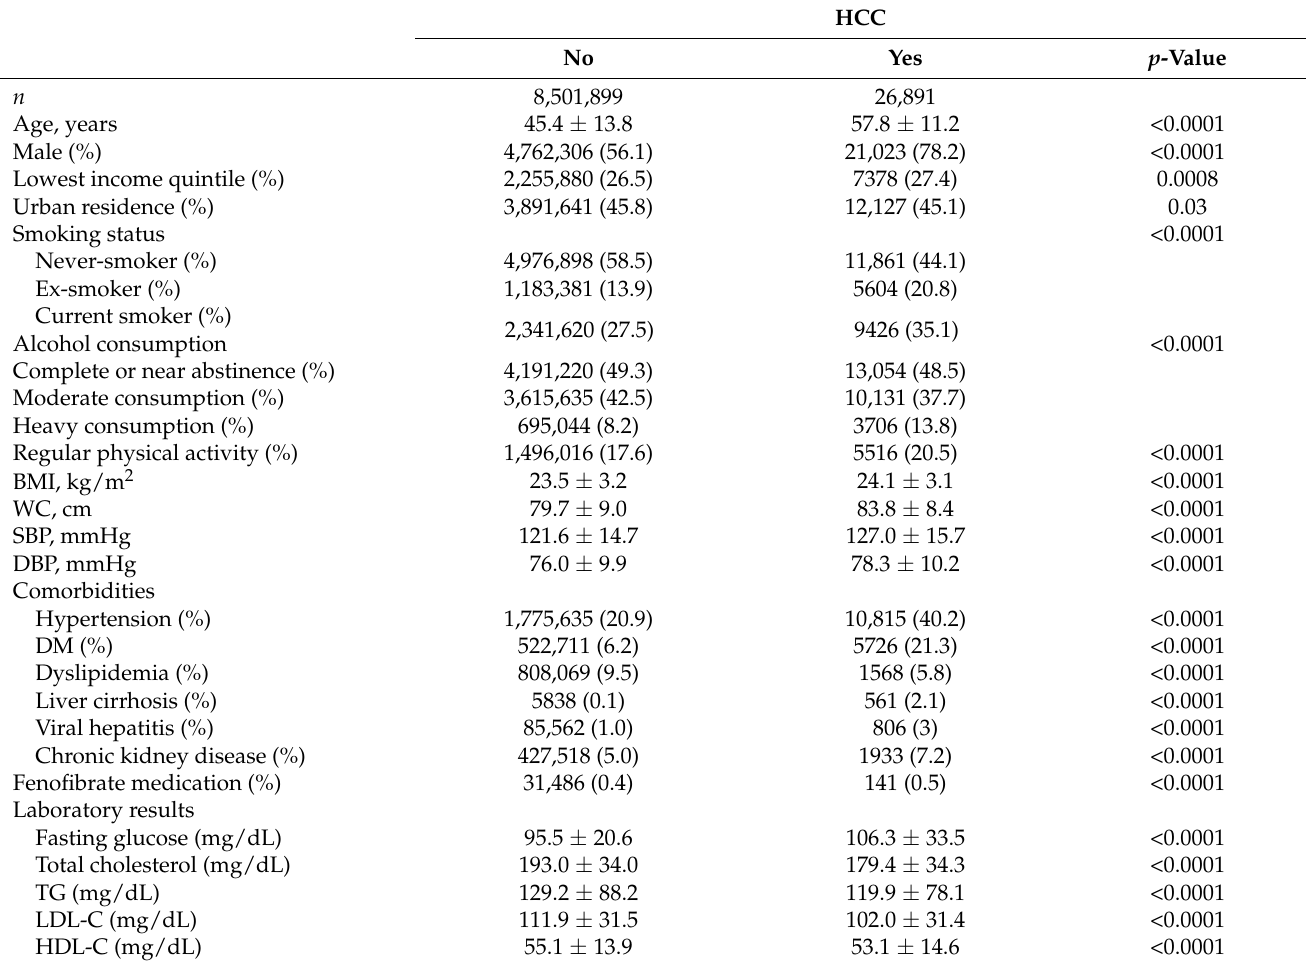
Table 1. Baseline characteristics of the study